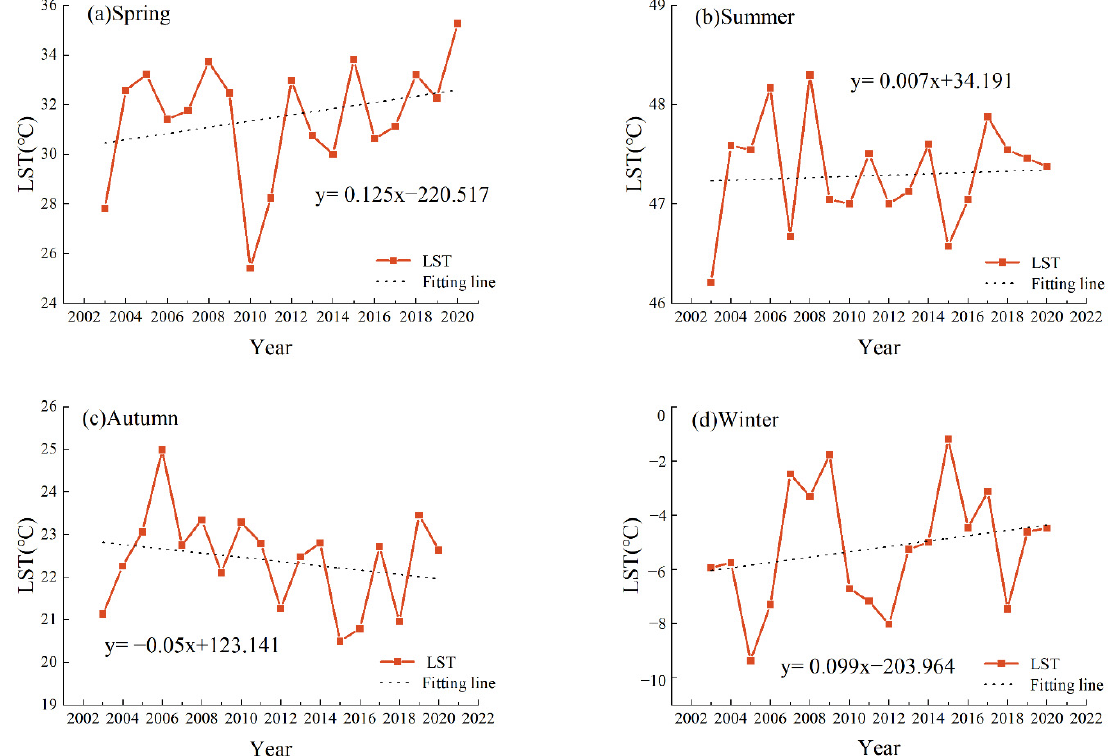
Figure 3. Seasonal LST change from 2003 to 2020.